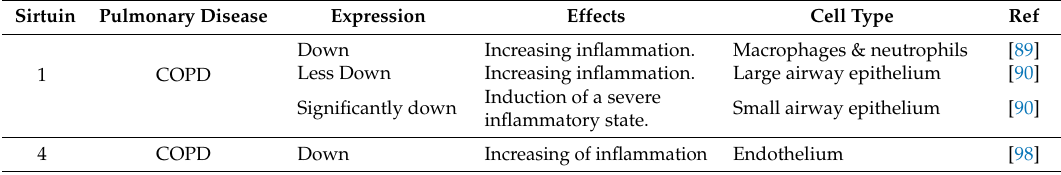
Table 3. Regulation and function of sirtuins in chronic obstructive pulmonary